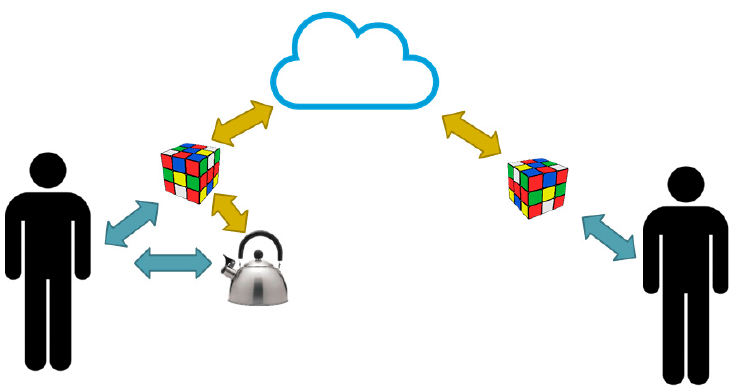
Figure 1. Interaction scenario for an IoTT system.